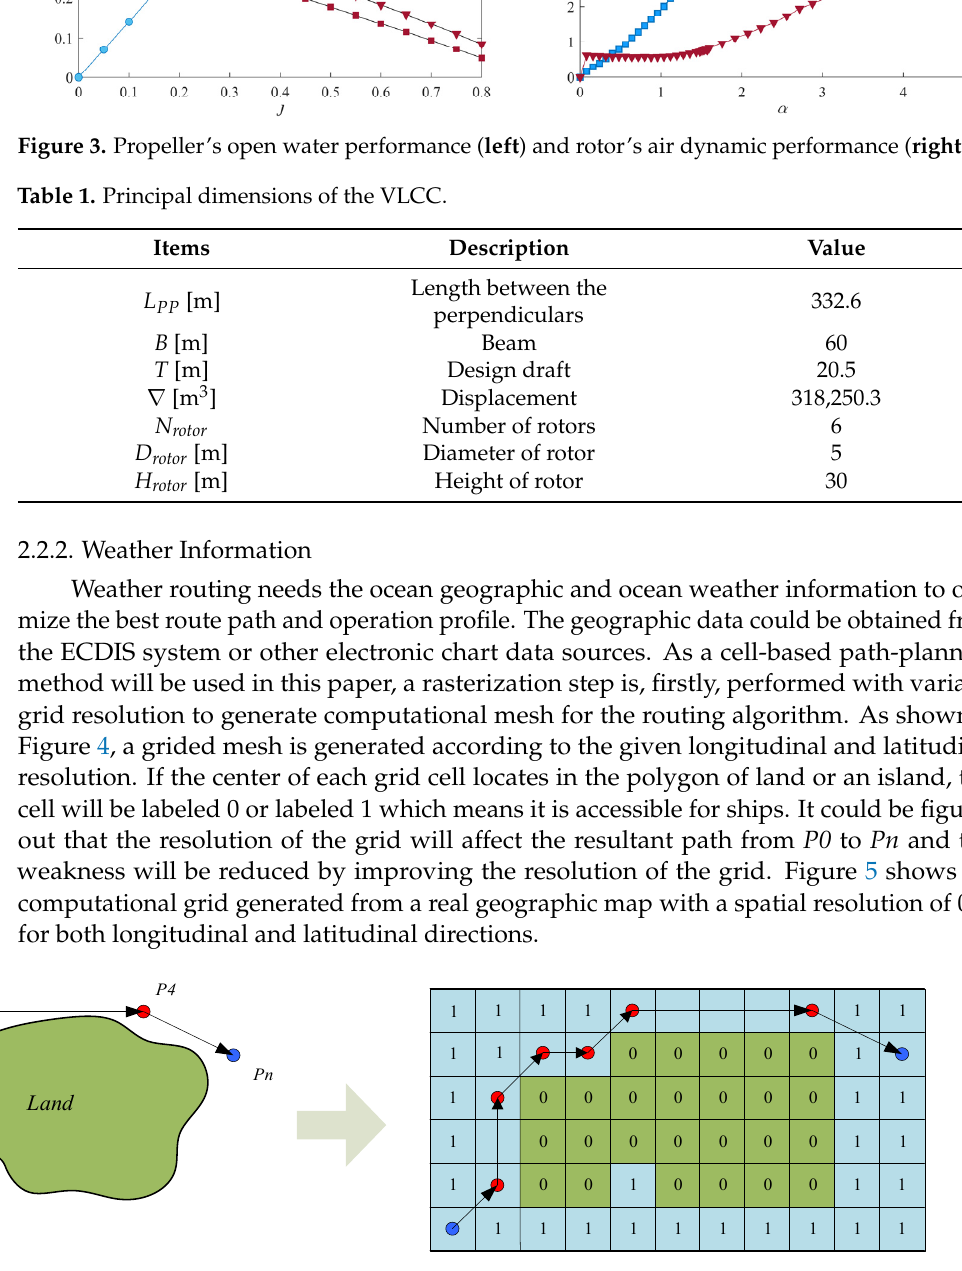
Figure 4. Discretization of geographic information.